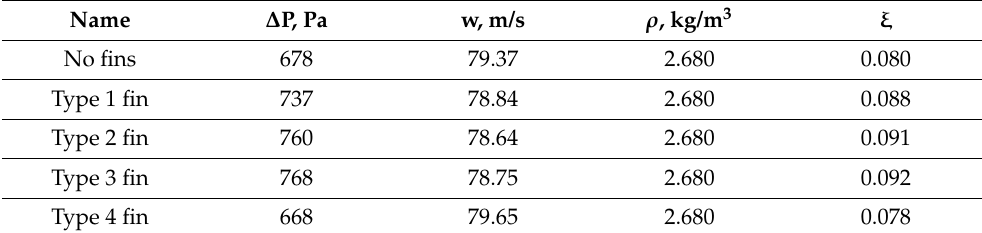
Table 3. Resistance coefficient as calculated.